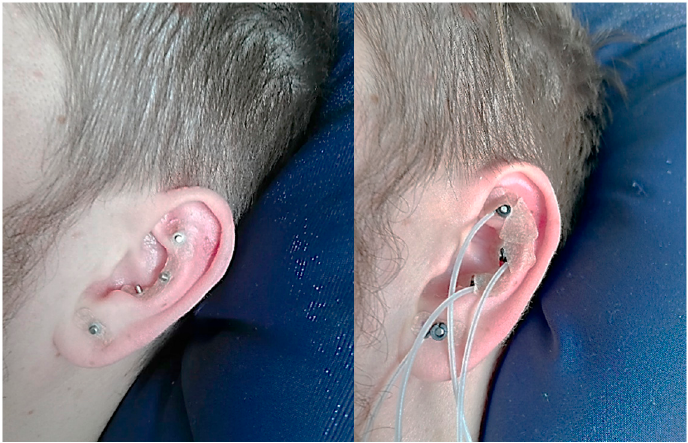
Figure 4. The location of four needle electrodes.